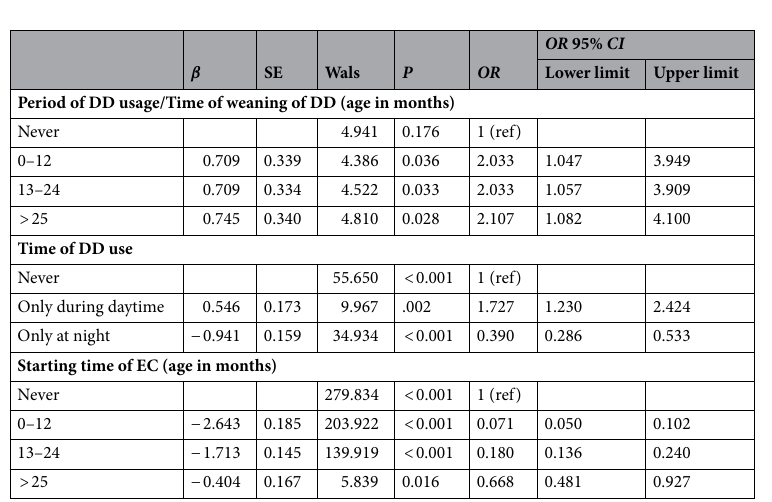
Table 3. Logistic regression analysis of factors influencing BBD prevalence. * P < 0.05 was considered statistically significant compared with the reference.